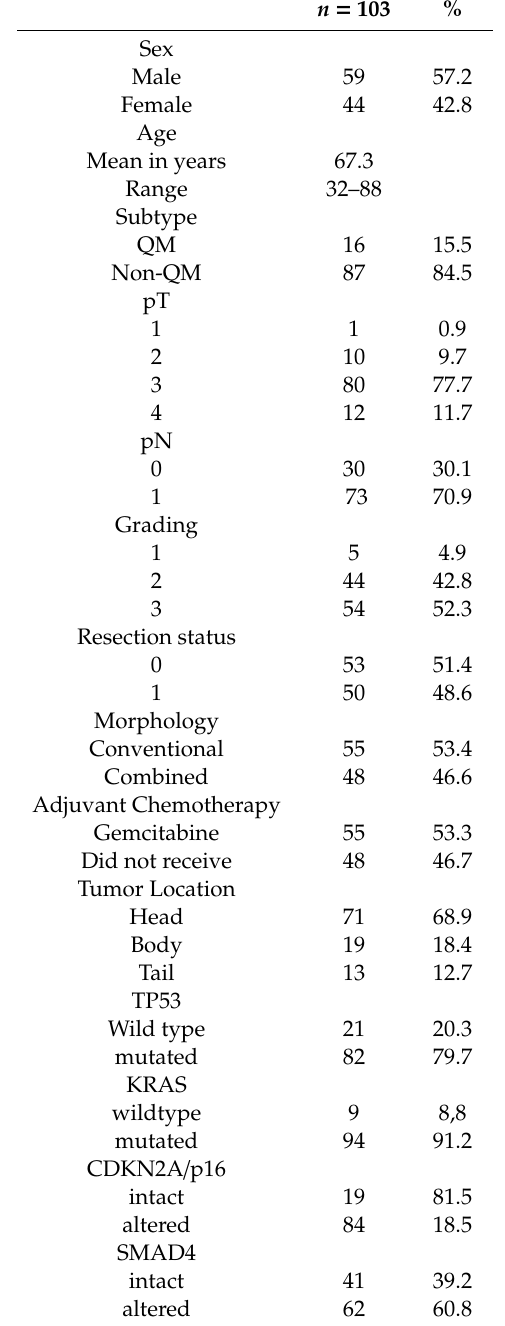
Table 1. Clinical and histopathological characteristics of the 103 patients included in the